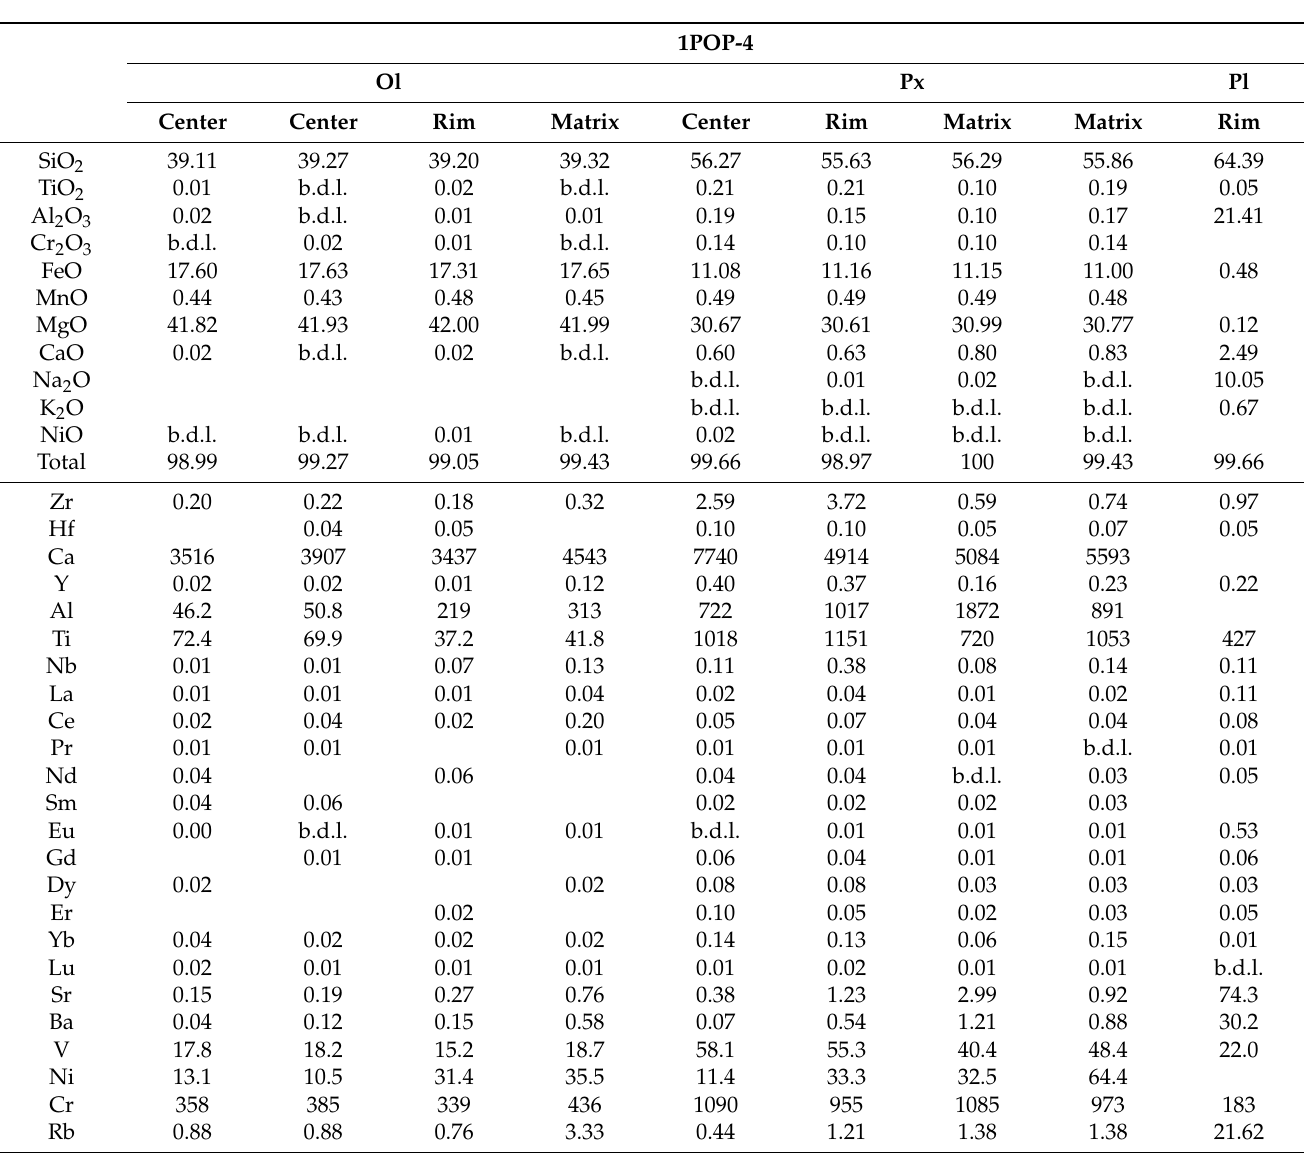
Table 4. Major (measured by EPMA, in wt.%) and trace (measured by SIMS, in ppm) elements in silicate minerals of 1POP-4 chondrule from the Kargapole